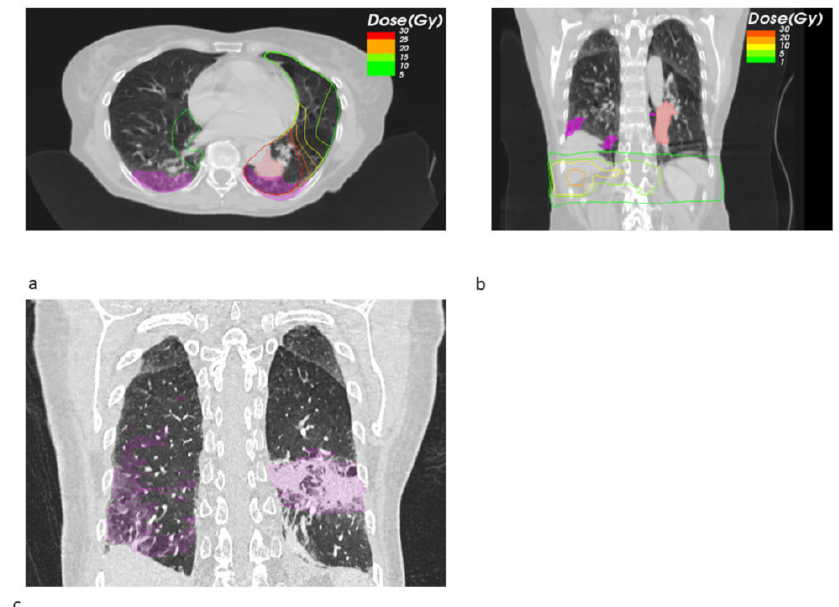
Figure 2. Transversal radiotherapy (RT) planning CT slices showing the sum EQD2 isodoses and pneumonitis contours (magenta) and GTV contours (light red) for a SBRT+ ICB case ( a ). This patient received simultaneous liver metastasis SBRT. The isodoses of the original treatment plan show a negligible lung dose ( b ). Figure ( c ) shows an exemplary sagittal slice from the follow-up CT showing the bilateral pneumonitis and its contours (magenta).